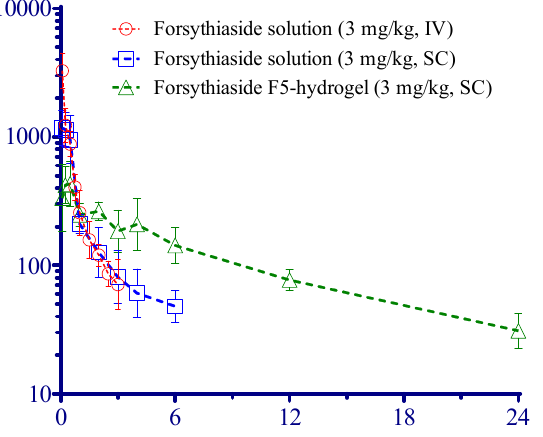
Figure 4. Concentration of forsythiaside in rat plasma vs. time curve after administration of drug (3 mg/kg, n = 4 for each group). Table 6. Pharmacokinetic parameters of FTS.